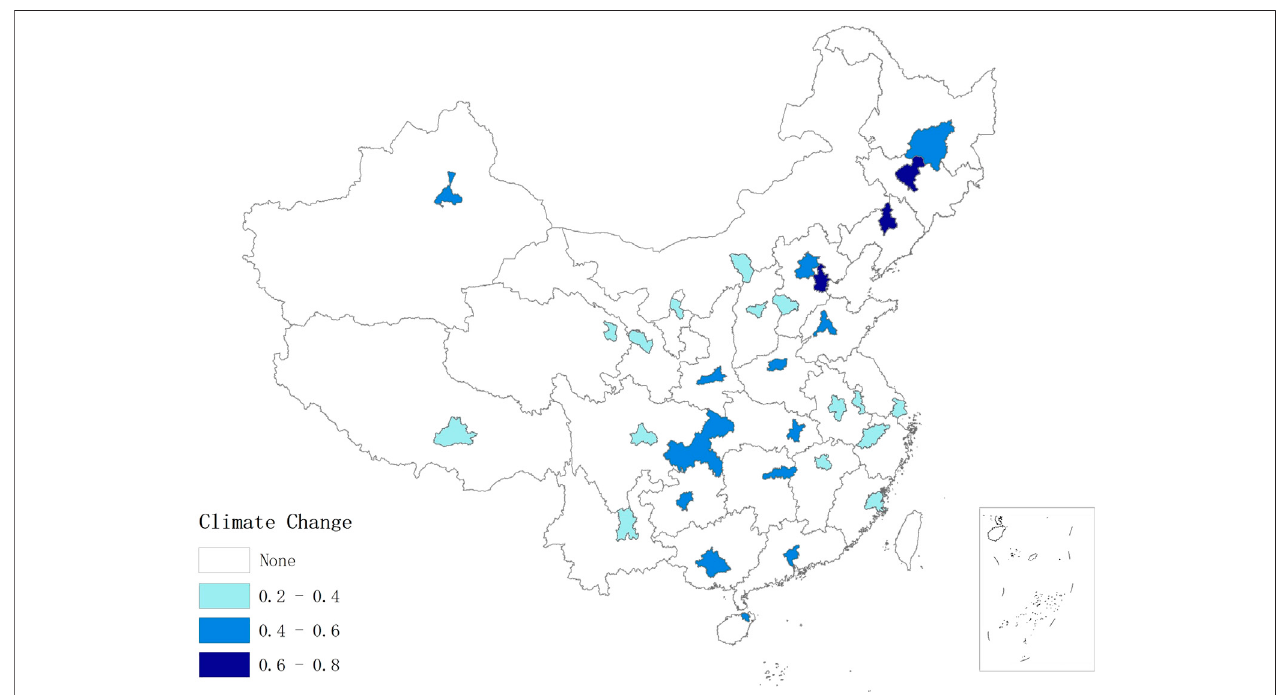
FIGURE 6 | Standard deviation of the average temperature in provincial capital cities and